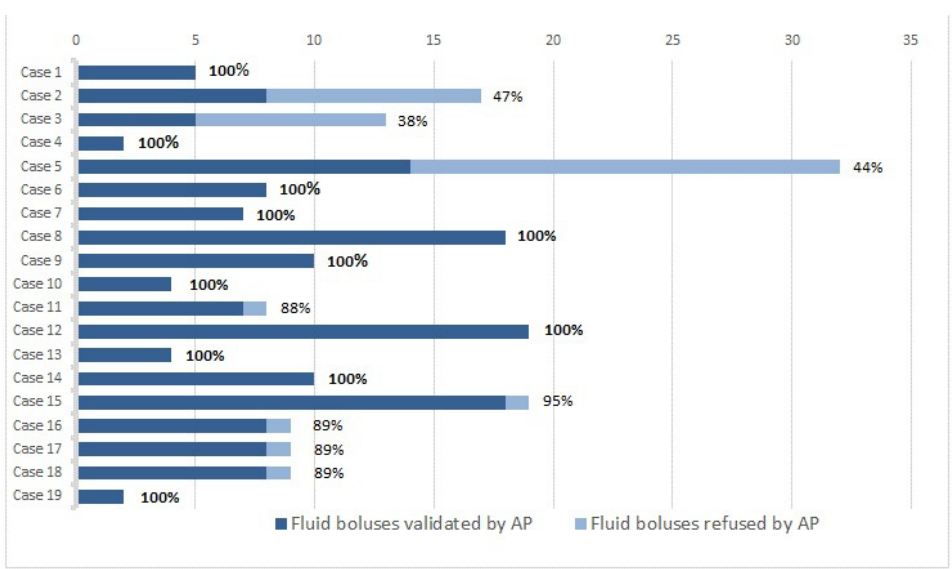
Percentage represents rate of fluid bolus approved by anaesthesiologist practitioner among fluid boluses suggested by LR Figure 2. Agreement between the closed-loop system and the anaesthesiologist. Figure 2. Agreement between the closed-loop system and the Table 2. Individual data for studied parameters per patient.